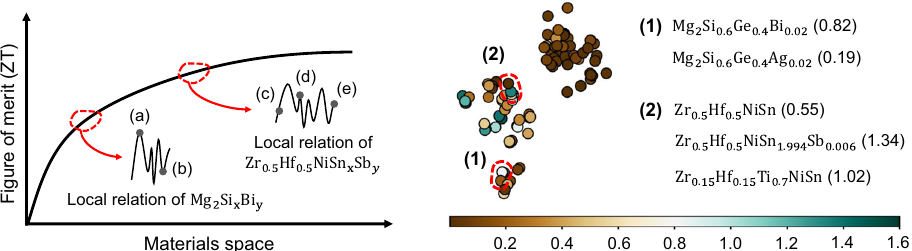
Fig. 1 Mixed distribution of thermoelectirc materials and their ZTs. a Conceptual materials space proportional to ZT at 700 K. Five example doped materials denoted by (a) – (e) are presented to describe severely nonlinear relations between the doped materials and ZT. (a) Mg 2 Si 0.9985 Bi 0.0015 (ZT = 0.64); (b) Mg 2 Si 0.999 Bi 0.001 (ZT = 0.32); (c) Zr 0.5 Hf 0.5 NiSn (ZT = 0.54). (d) Zr 0.5 Hf 0.5 NiSn 1.9998 Sb 0.002 (ZT = 1.45); (e)